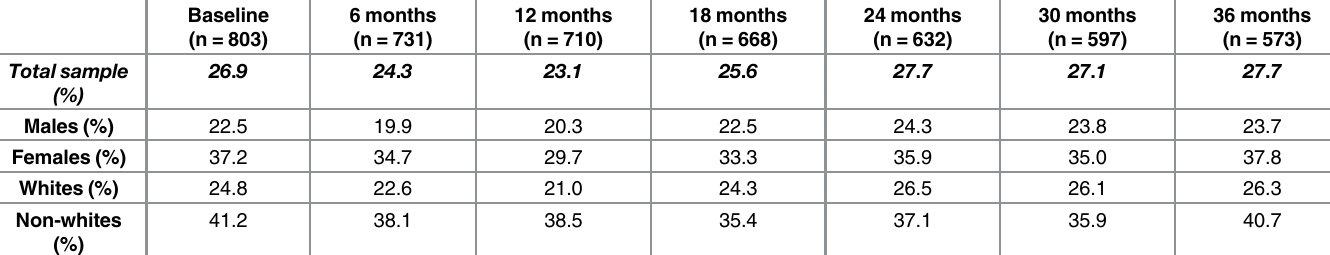
Table 2. Reporting of symptoms of distress (HADS with a cut-off of 12+) across time.